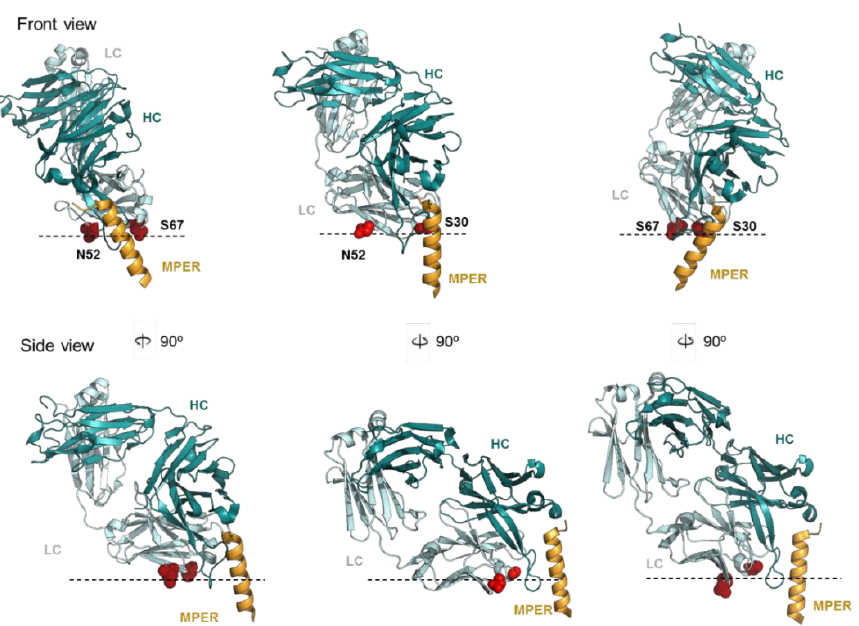
Figure 6. Binding models of 10E8 Fab to the helical MPER epitope inserted in membranes . The panels display front (top) and side views (bottom) of the Fabs oriented relative to the membrane (dotted lines) according to the Arg positions in the 2R mutants. Two features define the combination of S30R/N52R that enhances potency of the antibody (middle models): (i) the MPER helix with its main axis almost perpendicular to the membrane plane; and (ii) an adjacent LC β -sheet establishing full contact with the membrane